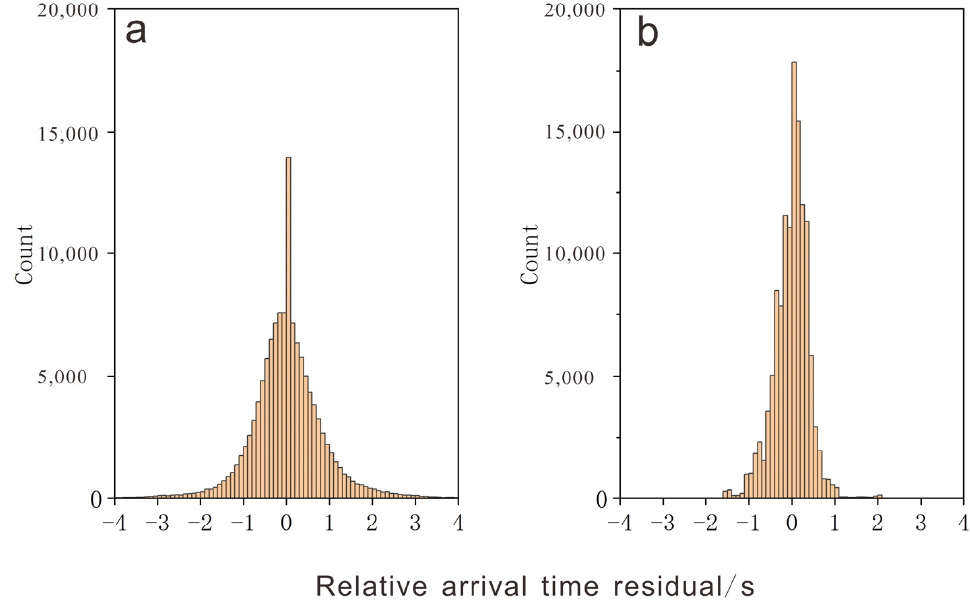
Figure 6. The sizes and distribution of the relative arrival-time residuals: ( a ) the initial model; ( b ) the solution model.